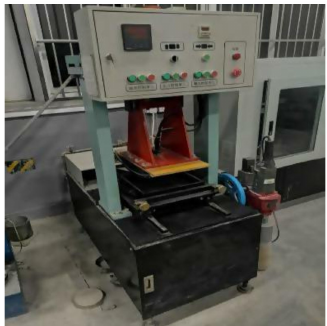
Figure 2. Wheel roller